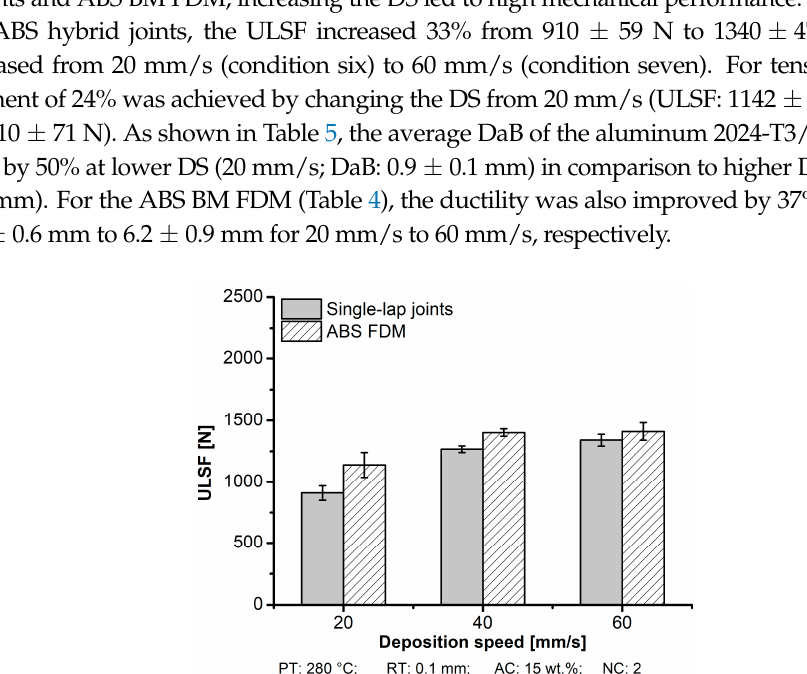
five, RT: 0.3 mm; the following parameters PT: 280 ◦ C, DS: 40 mm/s, AC: 15 wt.%, and NC: 2 were